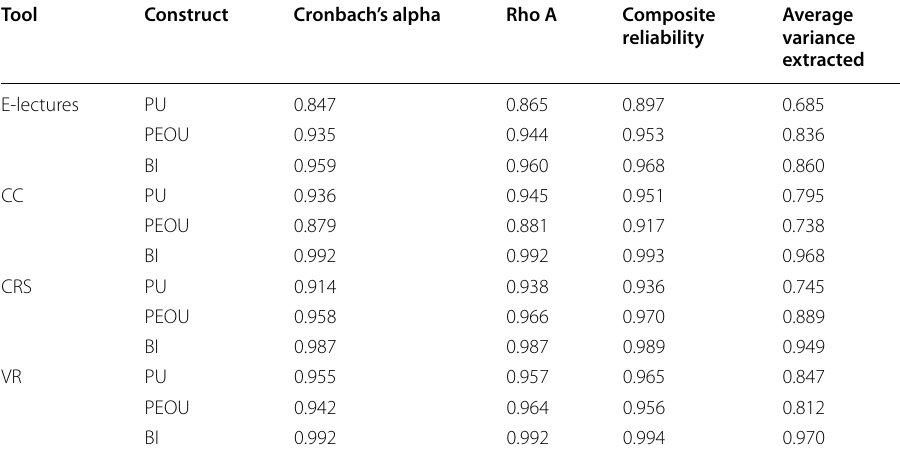
Table 2 Cronbach’s alpha, Rho A, Composite reliability and Average Variance Extracted (AVE) for the three constructs in the TAM model (Perceived Usefulness (PU), Perceived Ease of Use (PEOU), and Behavioral Intention (BI) for each tool